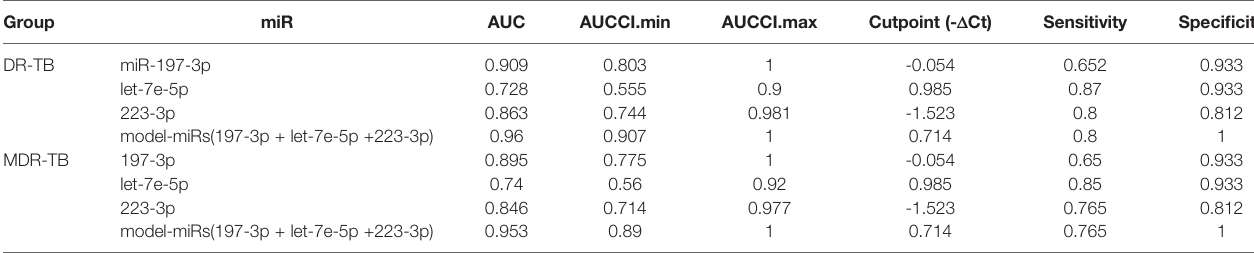
TABLE 2 | ROC analysis for DR-TB or MDR-TB groups vs Healthy subjects.